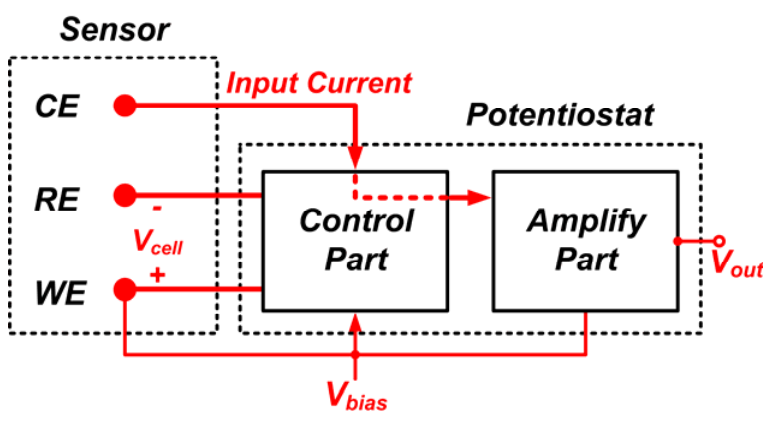
Figure 2. Block diagram of the single-ended